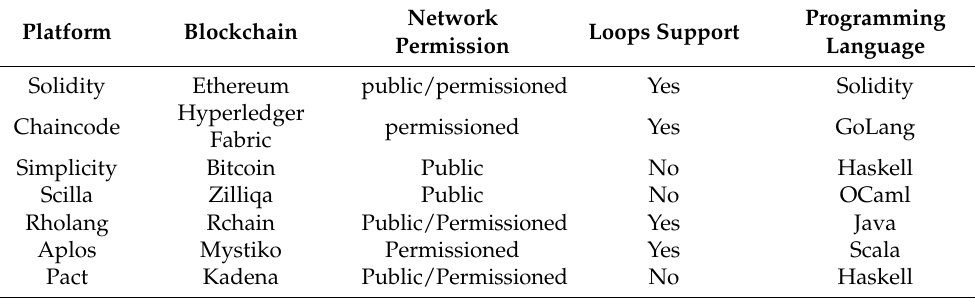
Table 1. A comparison of smart contract